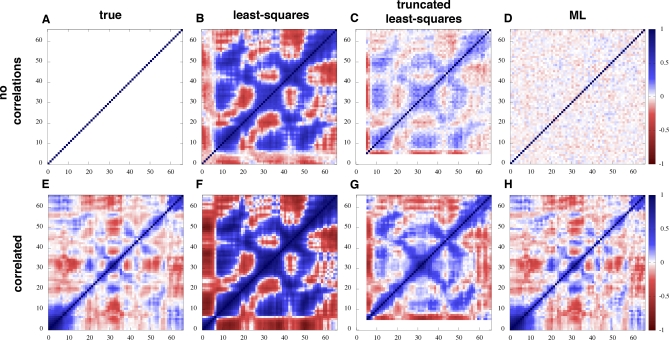
Plots of Correlation Matrices Inferred from SuperpositionsThe upper row (A–D) shows plots in which the true correlation matrix has no correlations (all off-diagonal elements are exactly zero), whereas the lower row (E–H) shows plots where the true correlation matrix has strong, complex, positive, and negative correlations. Positive correlation, zero correlation, and negative correlation are represented by colors ranging from blue to white to red, respectively.(A, E) The true, assumed correlation matrix used in the simulation.(B, F) The correlation matrix calculated from a least-squares superposition, including all atoms, of 300 protein structures simulated using the true correlation matrix.(C, G) The estimated correlation matrix, calculated from a least-squares superposition that omitted residues 1–5, which have the highest variance (most disorder) in the structure.(D, H) The correlation matrix calculated from a maximum likelihood superposition of the same simulated structures.